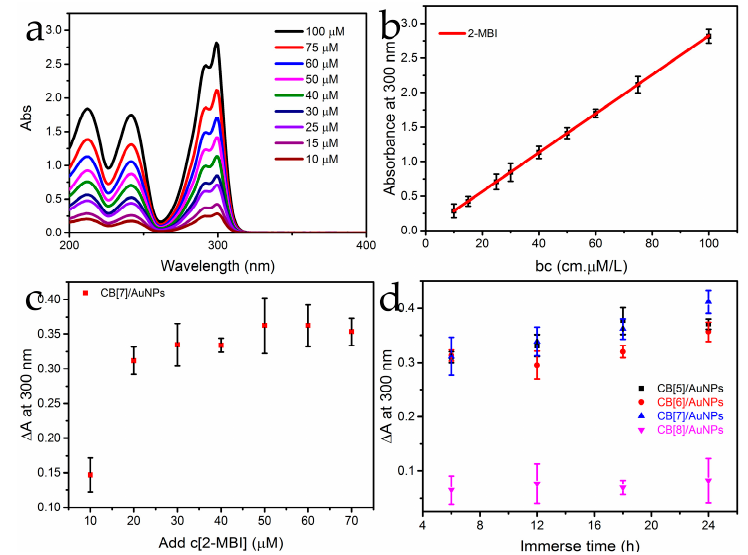
Figure 4. Adsorption experiments of 2-mercaptobenzimidazole (2-MBI) under 25 °C. ( a ) UV-VIS spectra of 2-MBI at different concentrations; ( b ) fitting plot for absorbance coefficient of 2-MBI; ( c ) concentration-dependent plot for CB[ 7 ]/AuNPs saturated with 2-MBI for 24 h; ( d ) time-dependent plot for CB[ n ]/AuNPs saturated with 2-MBI (100 μ M).